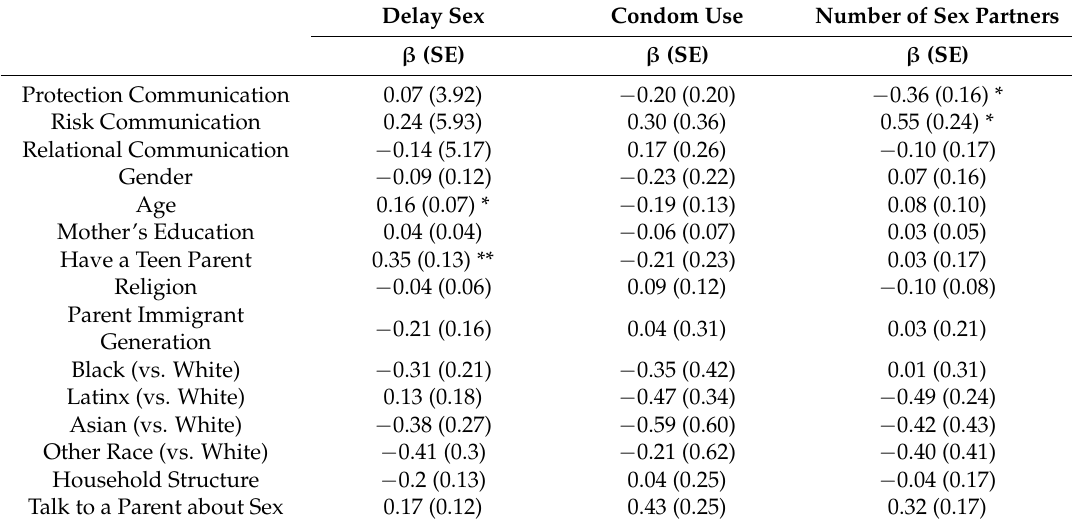
Table 1. Direct effects of extended-family (EF) communication on teen sexual behaviors. Delay Sex Condom